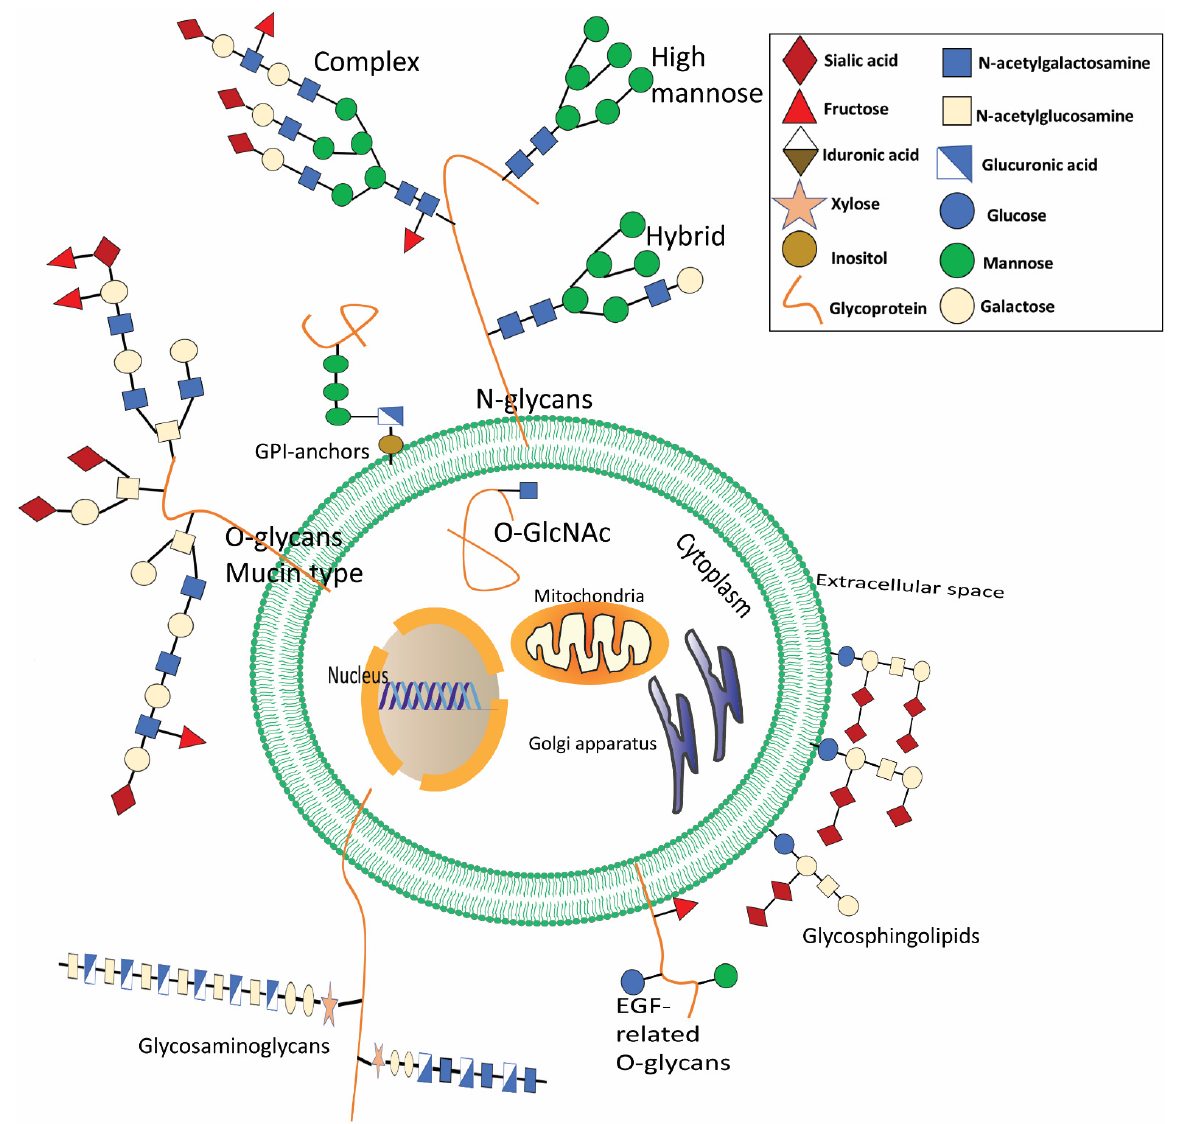
Figure 1. The most common glycoconjugates present in mammals are depicted. Glycans are present in a wide range of biomolecules. Glycosphingolipids are essential components of the cell’s external membrane. A reversible sequence of structures, called ceramide-linked glycans, are modified by terminal sialic acid. Glycosylation occurs when an N- or O-linked saccharide is attached covalently to Asp or Ser/Thr8 in the polypeptide backbone. N-Glycans all have the same basic structure (N- acetylgalactosamine), but they may be further subdivided into high mannose, hybrid, and complex forms, and their terminal structures can further be modified. When O-linked with Ser/Thr, it will develop mucin-type O, which is often seen in membrane-associated or secreted glycoproteins. Some glycoproteins are also linked to phosphatidylinositol in the plasma membrane’s outer leaflet, called glycosylphosphatidylinositol (GPI) linked proteins. Less common O-glycans may alter epidermal growth factor (EGF)-like repeats (O-fucose, O-glucose, and O-linked N-acetylglucosamine). Glycosaminoglycans are longitudinal co-polymers of acidic disaccharide repeating units found as hyaluronic acid or connected to proteoglycans in the extracellular matrix. Glycosaminoglycans may be sulfated at the N-site (NS) or at multiple O-sites, including 2-O-sulfation (2S), 4-O-sulfation (4S), and 6-O-sulfation (6S). Glycosphingolipids are ceramide-linked glycans that dominate the exterior cellular membranes. In addition, O-GlcNAcylation adds O-linked N-acetylglucosamine to various cytoplasmic and nuclear